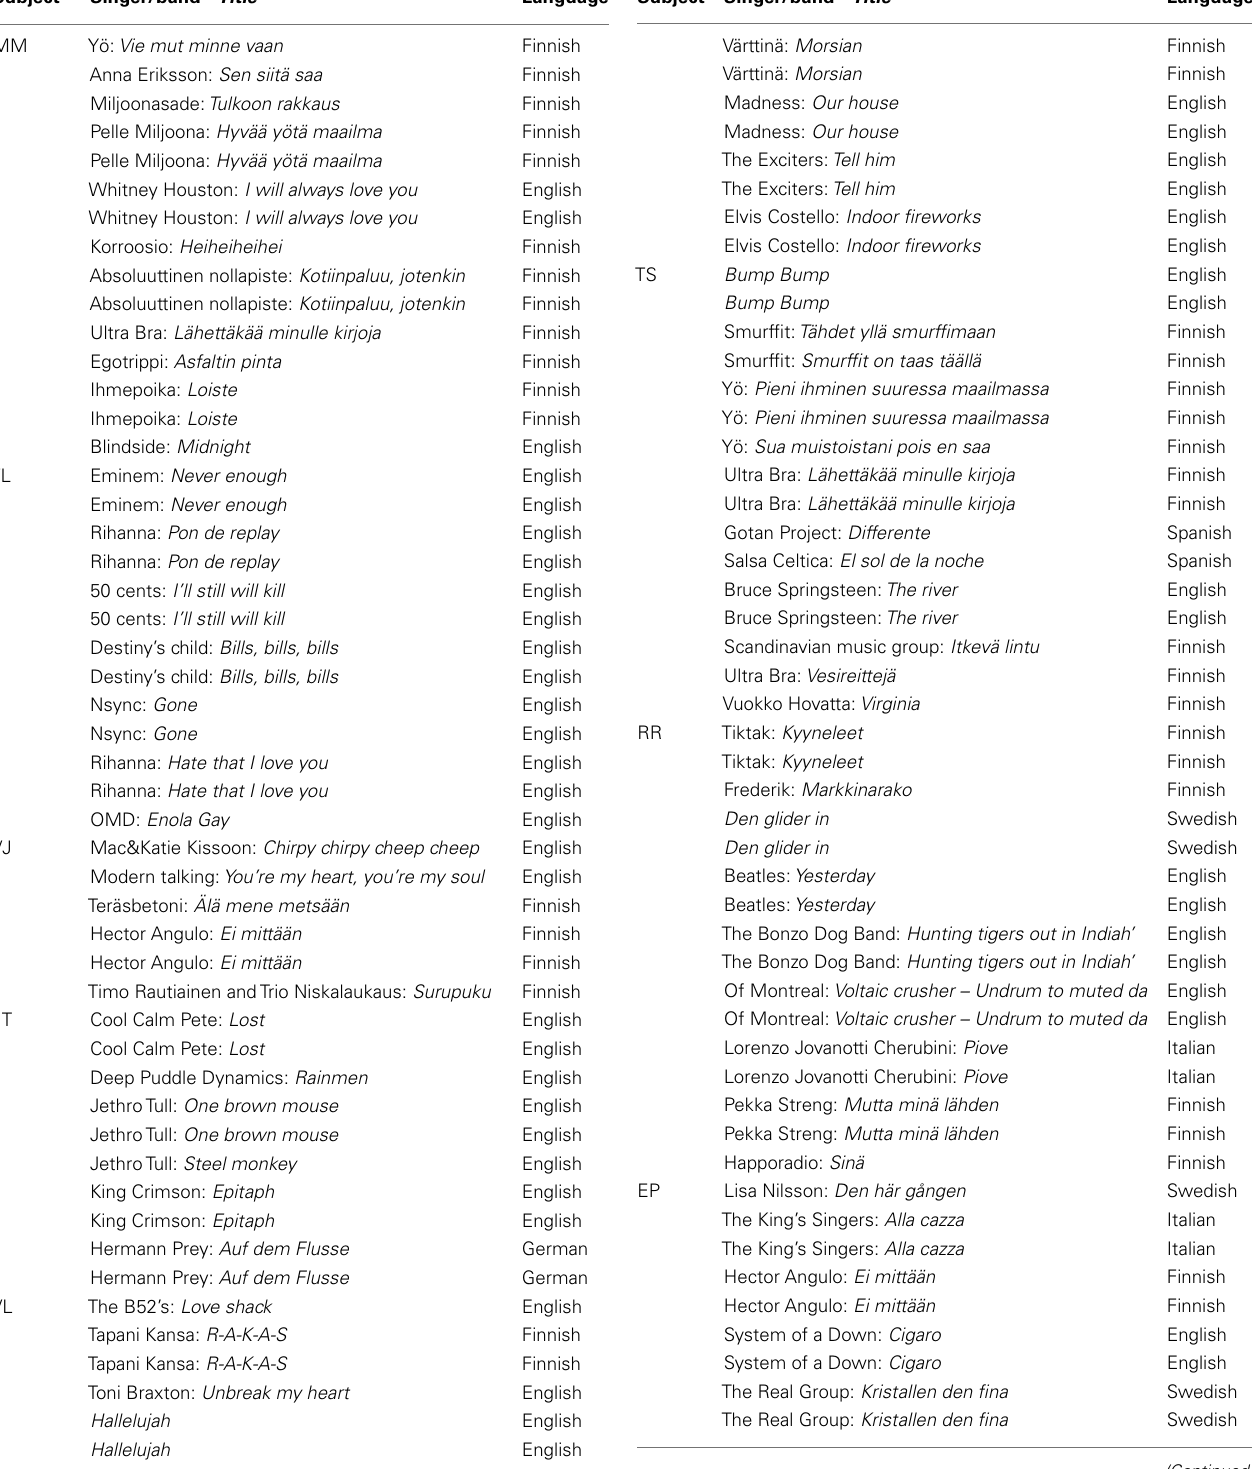
TableA1 |Artist, title and language of each song from which a musical stimulus with lyrics was extracted per each